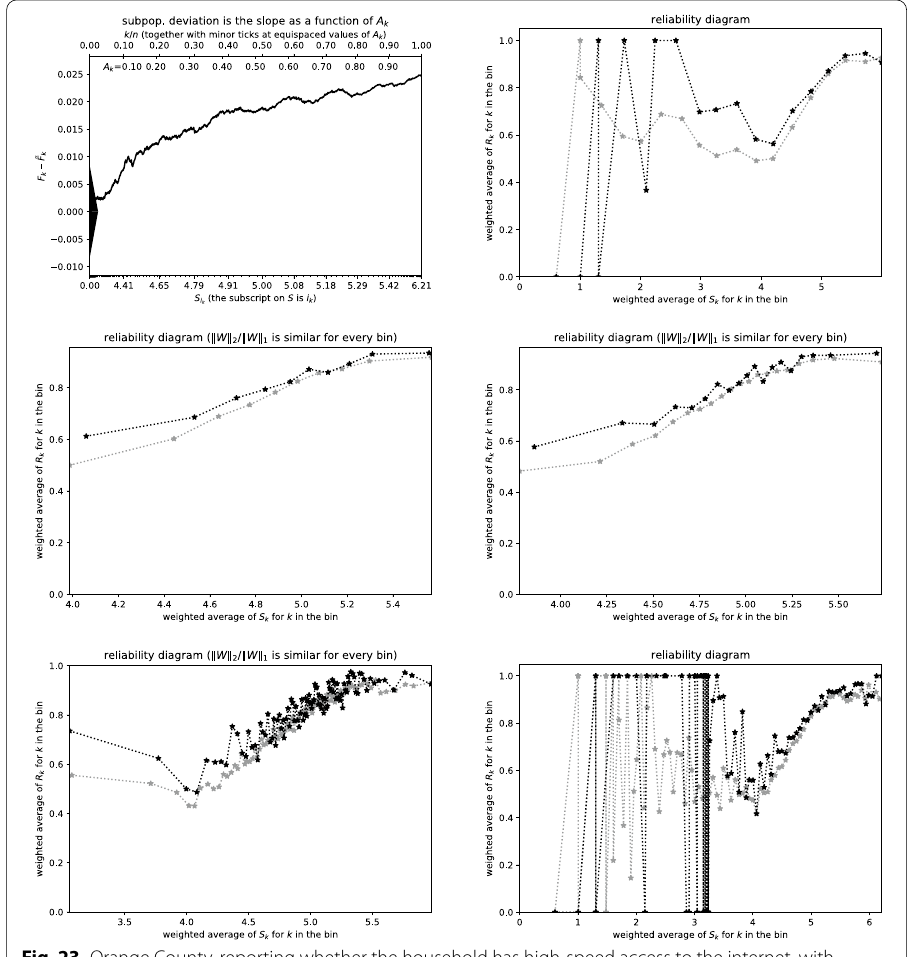
Fig. 23 Orange County, reporting whether the household has high-speed access to the internet, with scores being log 10 of the adjusted household income; n = 10,680; Kuiper’s statistic is 0.02499 /σ = 6.013 , Kolmogorov’s and Smirnov’s is 0.02484 /σ = 5.979 . The severe deviation at the very lowest scores is misleadingly underestimated in the reliability diagrams with 10 or 20 bins each, even as compared to the diagrams with around 100 bins each. However, the diagrams with around 100 bins each are far too noisy for other scores. Only the plot of cumulative differences resolves the severe deviation at the lowest scores while being informative at the other scores, too. The scalar summary statistics indicate that the overall deviation is highly statistically